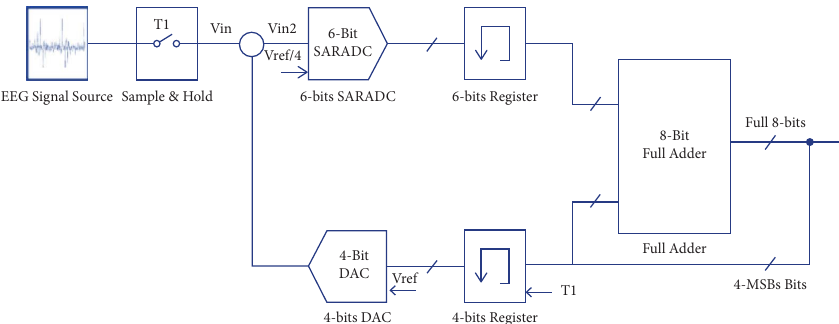
Figure 25: Te block diagram of SAR ADC in [67].